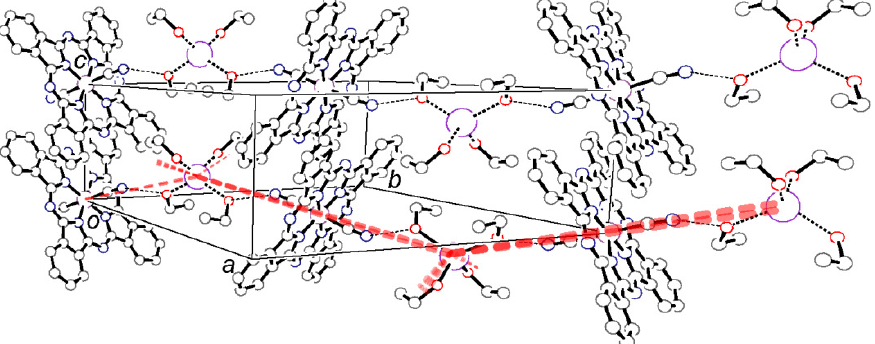
Figure 3. Hydrogen-bonding chain in K[Co(Pc)(CN) indicates the zigzag chain composed of [Co(Pc)(CN)